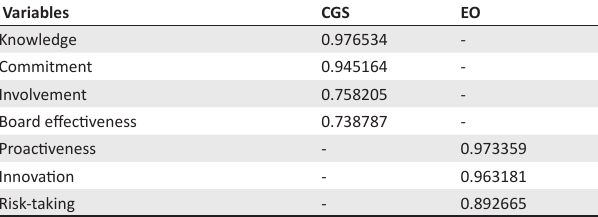
FIGURE 2: Canonical variance between the weighted sum of the scales of corporate governance systems and entrepreneurial TABLE 5: Factor structure of the first root of corporate governance systems and entrepreneurial orientation.